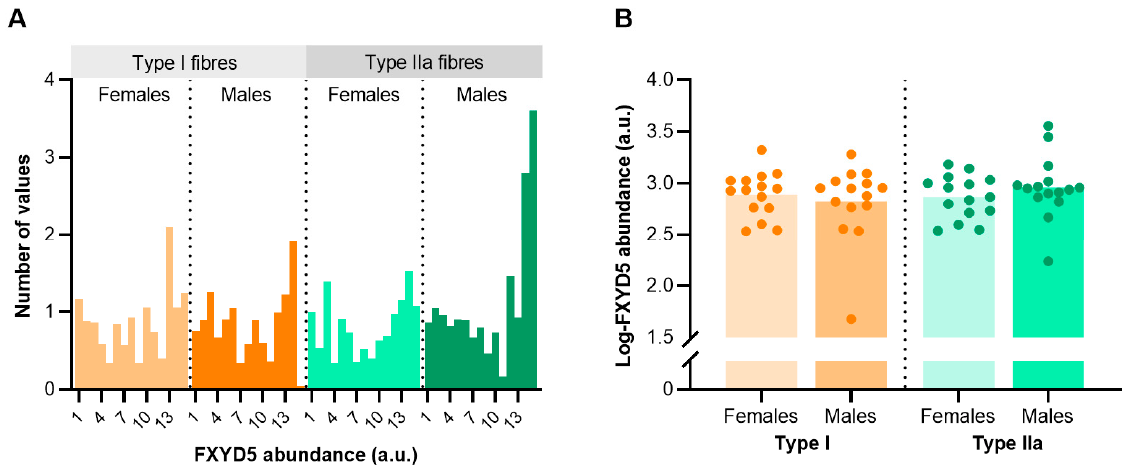
Figure 4. FXYD5 abundance in human skeletal muscle type I and IIa fibres of healthy young females ( n = 15) and males ( n = 15). ( A ) Frequency distribution of FXYD5 abundance before log-transformation. ( B ) Individual data points for both sexes and fibre types. Bars represent sample means.